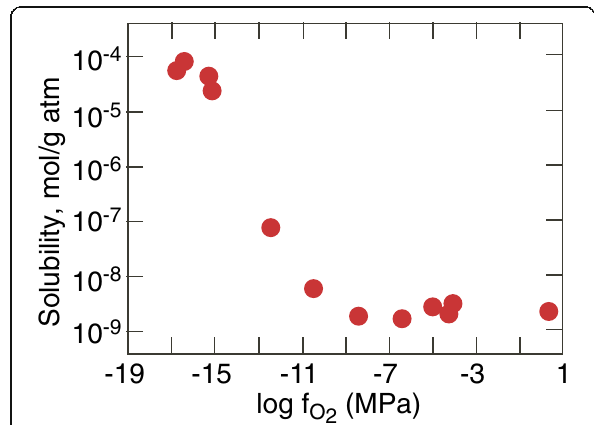
Fig. 17 Nitrogen solubility in basalt melt as a function of oxygen fugacity at ambient pressure and high temperature (data from Libourel et al.